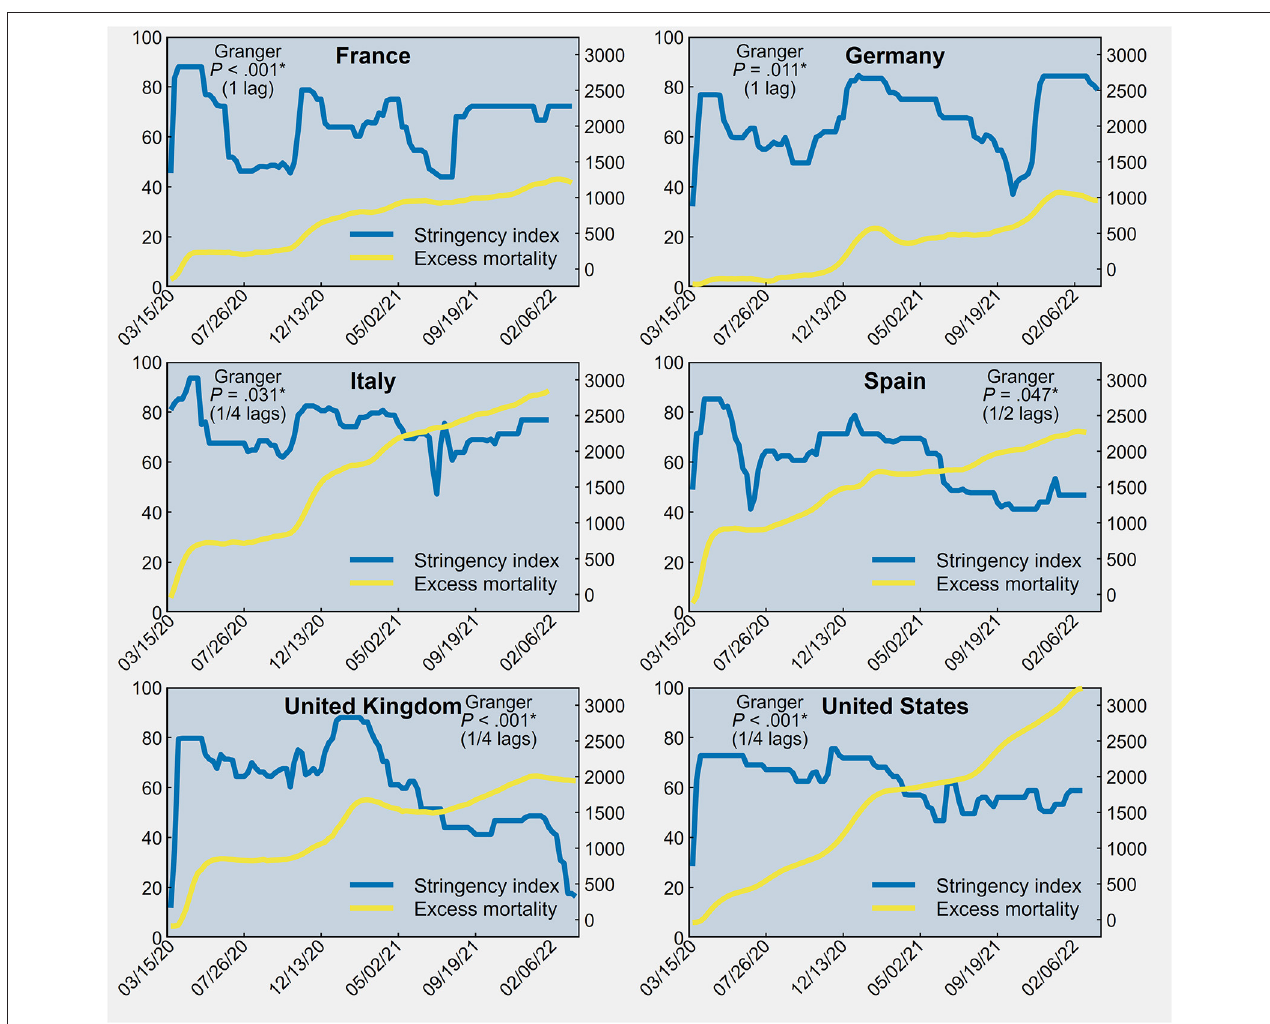
FIGURE 1 | Stringency index (first y- axis) and cumulative excess mortality per million population (second y- axis) between March 15, 2020 and March 20, 2022 in France, Germany, Italy, Spain, the United Kingdom and the United States of America.